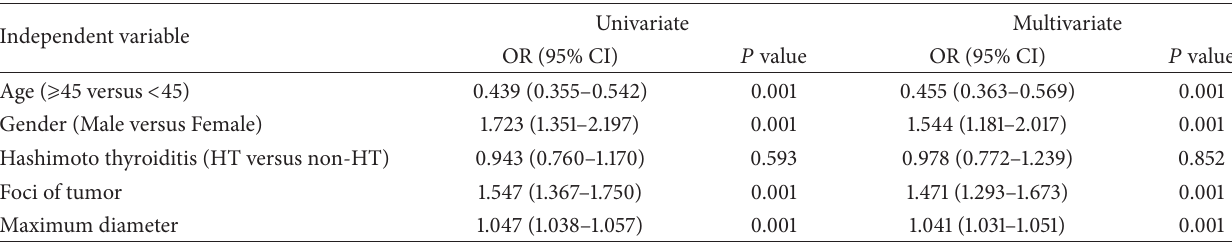
Table 3: Univariate and multivariate analysis for LNM in PTCs.